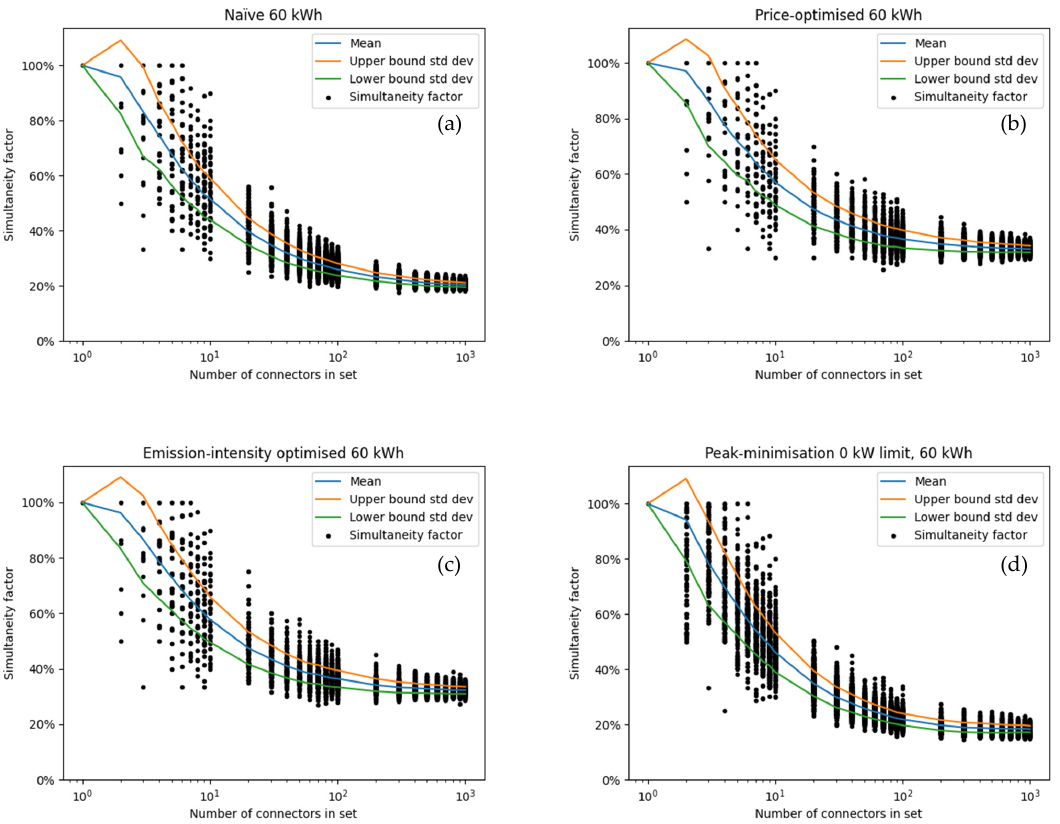
Figure A6. Coincidence factor assuming 60 kWh per CE for ( a ) naive charging; ( b ) price-optimised charging; ( c ) CO 2 intensity optimised charging; ( d ) peak power optimised charging. Note that peak power was optimised for all C simultaneously. Optimizing for each set in ( d ) for a low simultaneity factor likely results in significantly lower values. For the larger sets, the difference is minor. The blue line shows the mean across the randomly selected sets, and the orange and green lines the upper and lower boundaries of the standard deviation. Each randomly selected set was of the size shown on the x -axis.